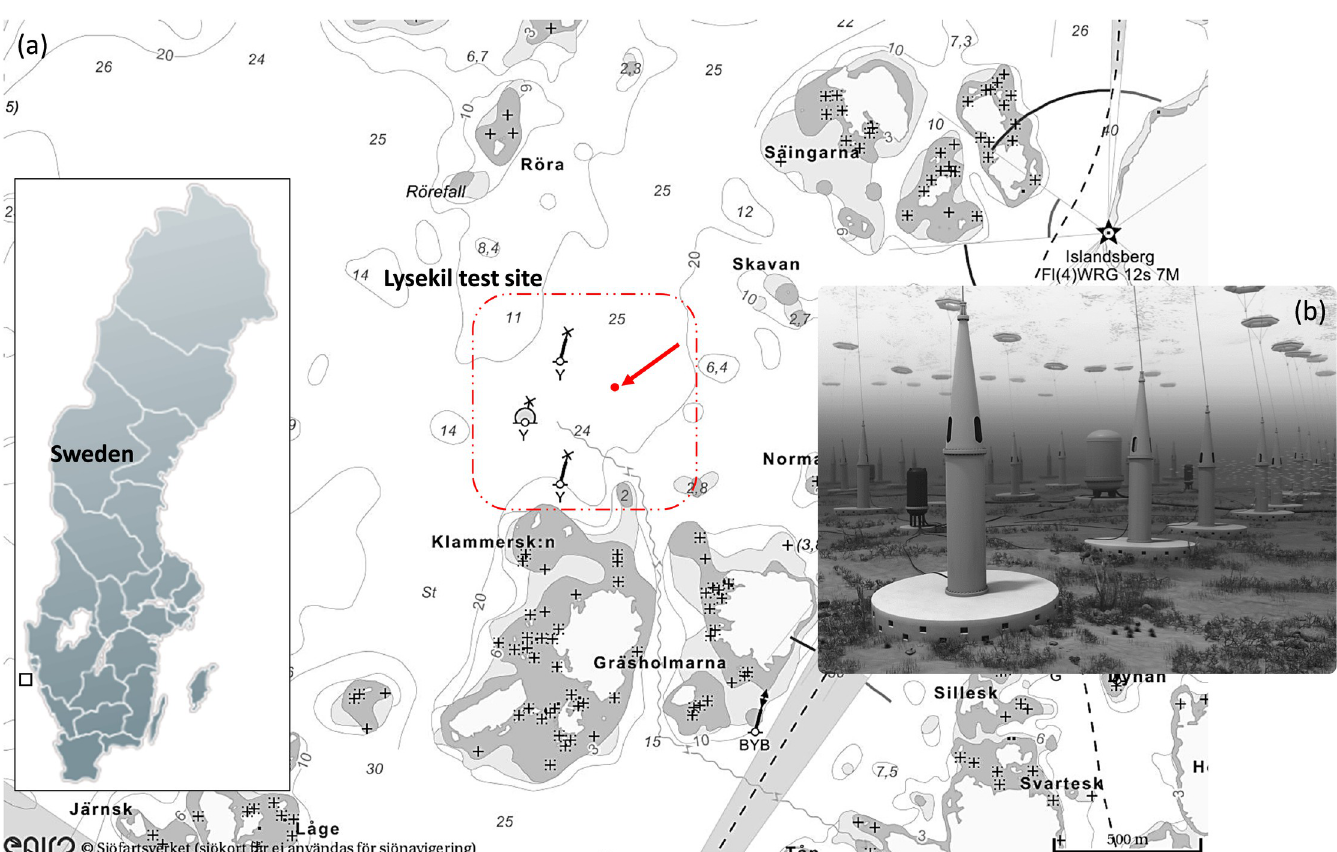
Fig 1. Location of the Lysekil research site on the west coast of Sweden. (a) The arrow indicates where the sonar platform was deployed. (b) Computer rendering of the subsea environment within the test site.